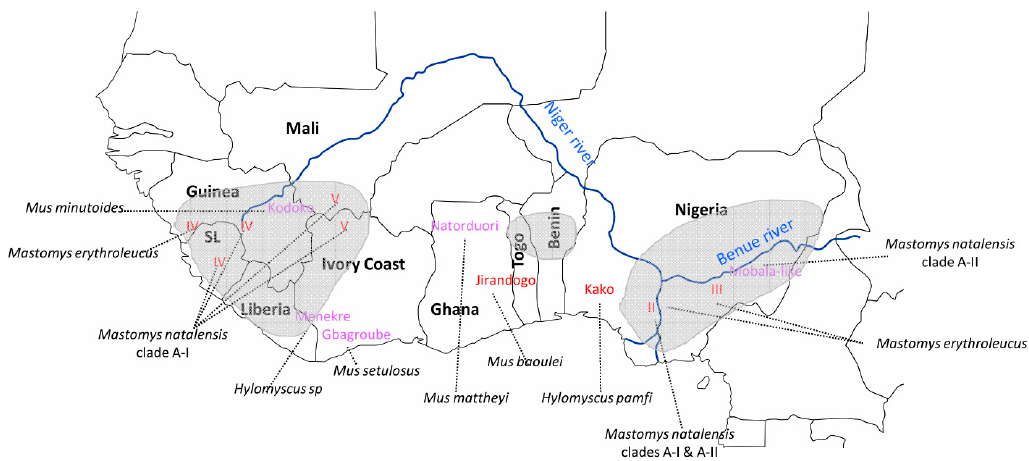
Figure 1. Lassa virus (LASV) lineages (in red) and arenaviruses (in purple) detected in rodents across Western Africa (with host species indicated in italics and connected by dashed lines to corresponding viruses). Endemic foci for Lassa fever are shaded in grey. Respective country names appear within the map in bold black.